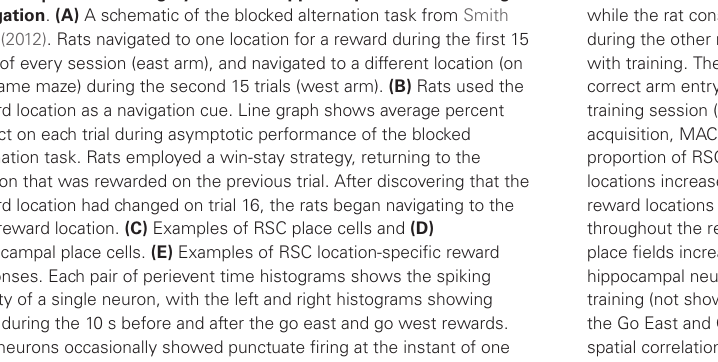
FIGURE 3 | Neural coding by RSC and hippocampal neurons during navigation . (A) A schematic of the blocked alternation task from Smith et al. (2012). Rats navigated to one location for a reward during the first 15 trials of every session (east arm), and navigated to a different location (on the same maze) during the second 15 trials (west arm). (B) Rats used the reward location as a navigation cue. Line graph shows average percent correct on each trial during asymptotic performance of the blocked alternation task. Rats employed a win-stay strategy, returning to the location that was rewarded on the previous trial. After discovering that the reward location had changed on trial 16, the rats began navigating to the new reward location. (C) Examples of RSC place cells and (D) hippocampal place cells. (E) Examples of RSC location-specific reward responses. Each pair of perievent time histograms shows the spiking activity of a single neuron, with the left and right histograms showing firing during the 10 s before and after the go east and go west rewards. RSC neurons occasionally showed punctuate firing at the instant of one